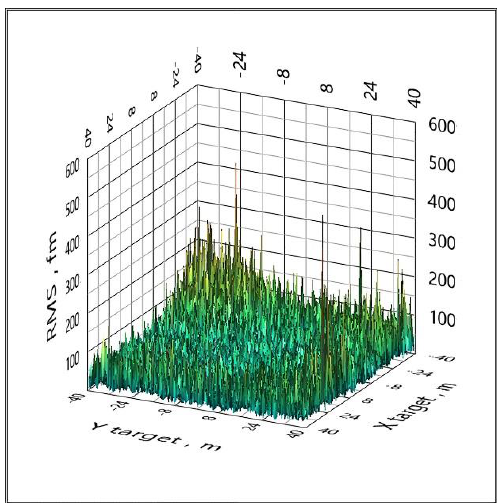
Figure 6. The distribution of the RMS (1 femtometer (fm) = 10 −15 m) coordinate estimate over the area when Gaussian noise is added to the TDoA values with a standard deviation of 0 ps (LPS). Sensors 2020 , 20 , x FOR PEER REVIEW